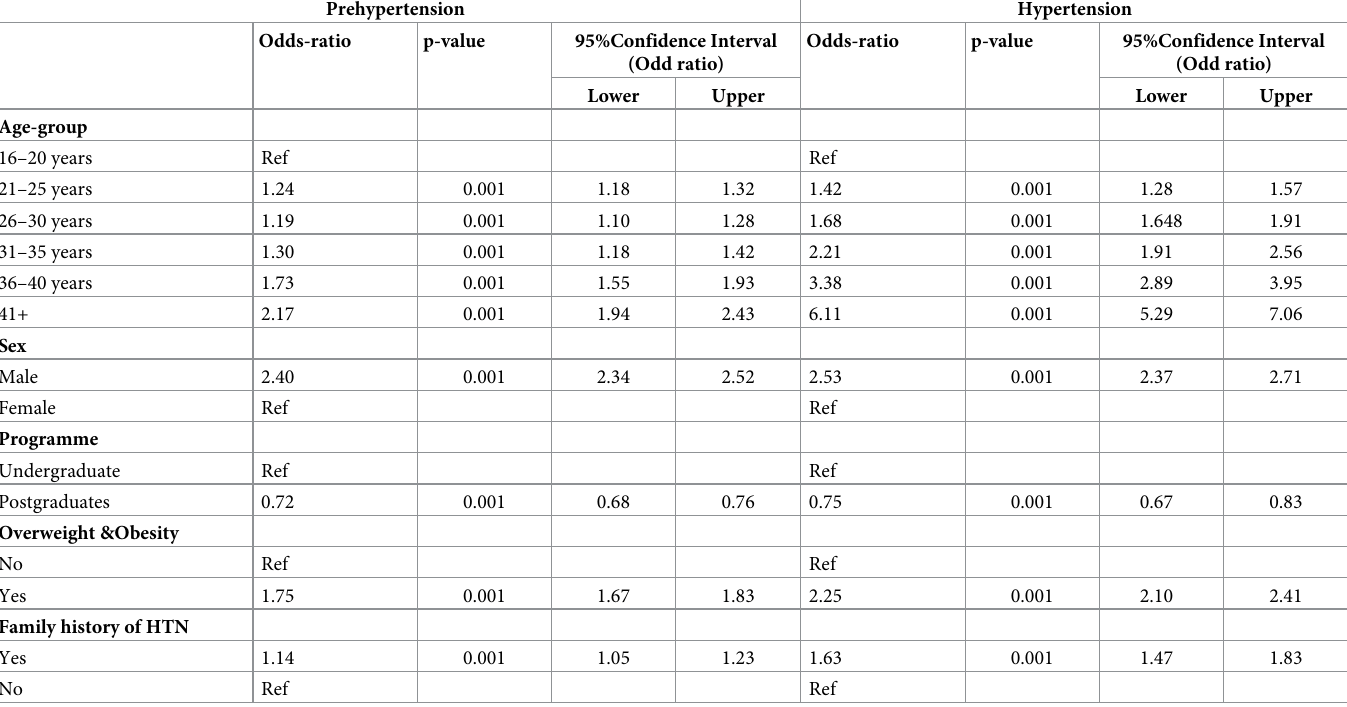
Table 7. Multivariate analysis showing the association between socio-demographic characteristics of students and prehypertension and